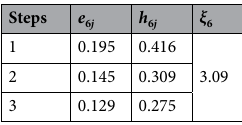
Table 8. Section 4 calculation parameters.